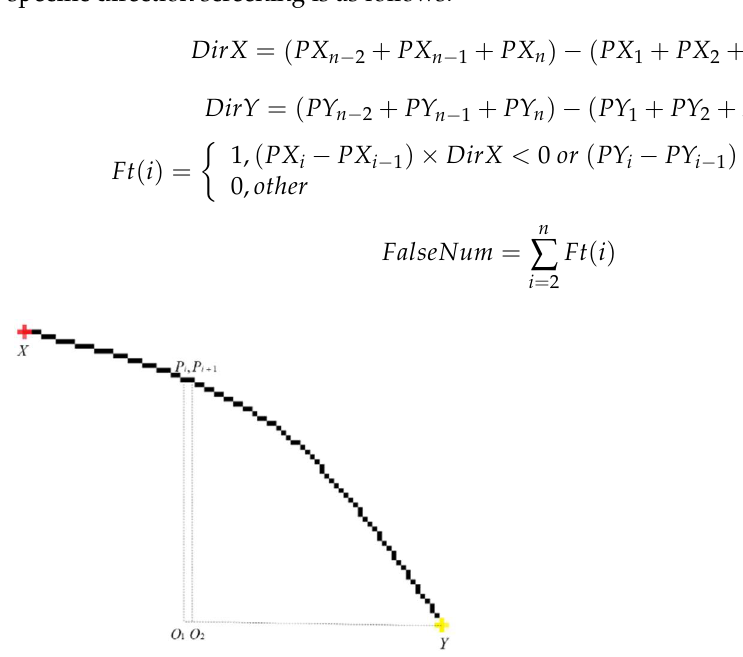
vertical coordinates of the 𝑖 point, respectively. 𝐷𝑖𝑟𝑋 and 𝐷𝑖𝑟𝑌 record the direction of